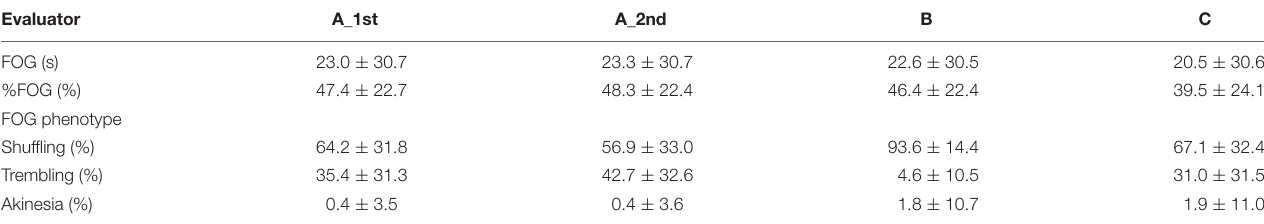
TABLE 1 | Freezing of gait (FOG) scoring by each evaluator (157 video data collected from 21 patients). Evaluator